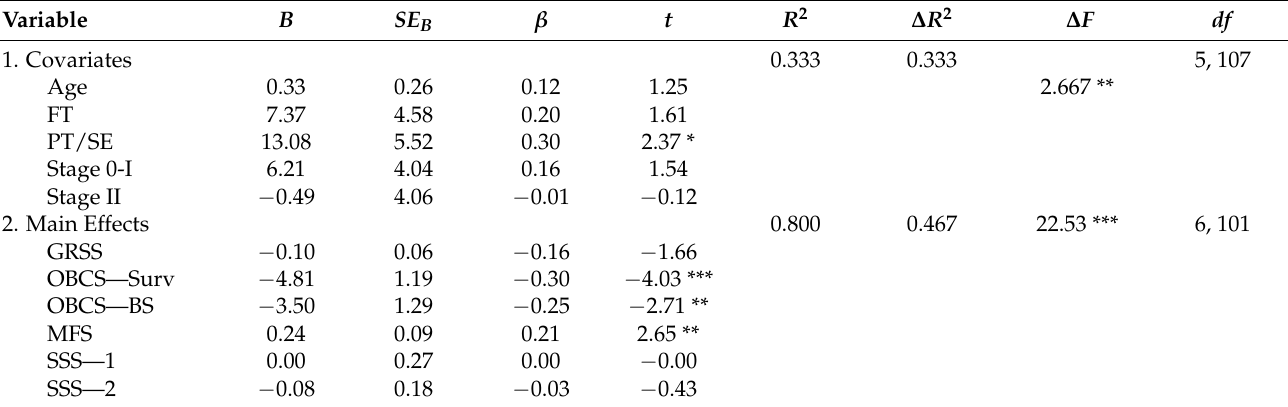
Table 5. Hierarchical regression analysis for gender socialization variables predicting EES